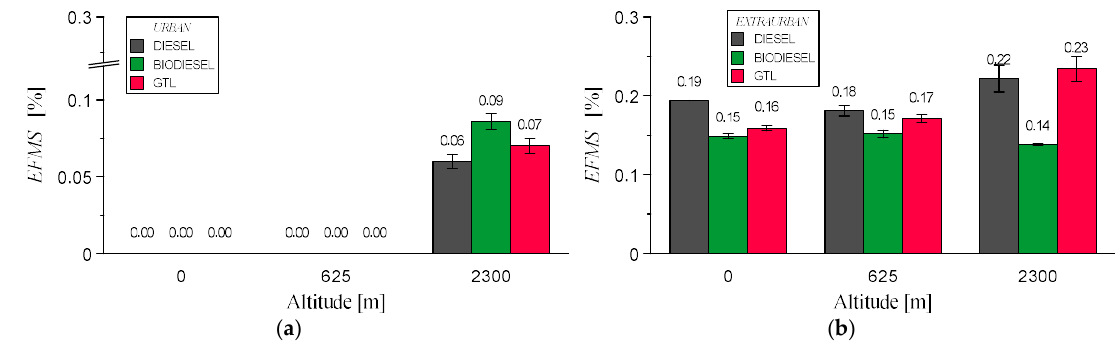
Figure 9. Estimated fuel mass savings: ( a ) Urban driving conditions, ( b ) Extra-urban driving conditions.